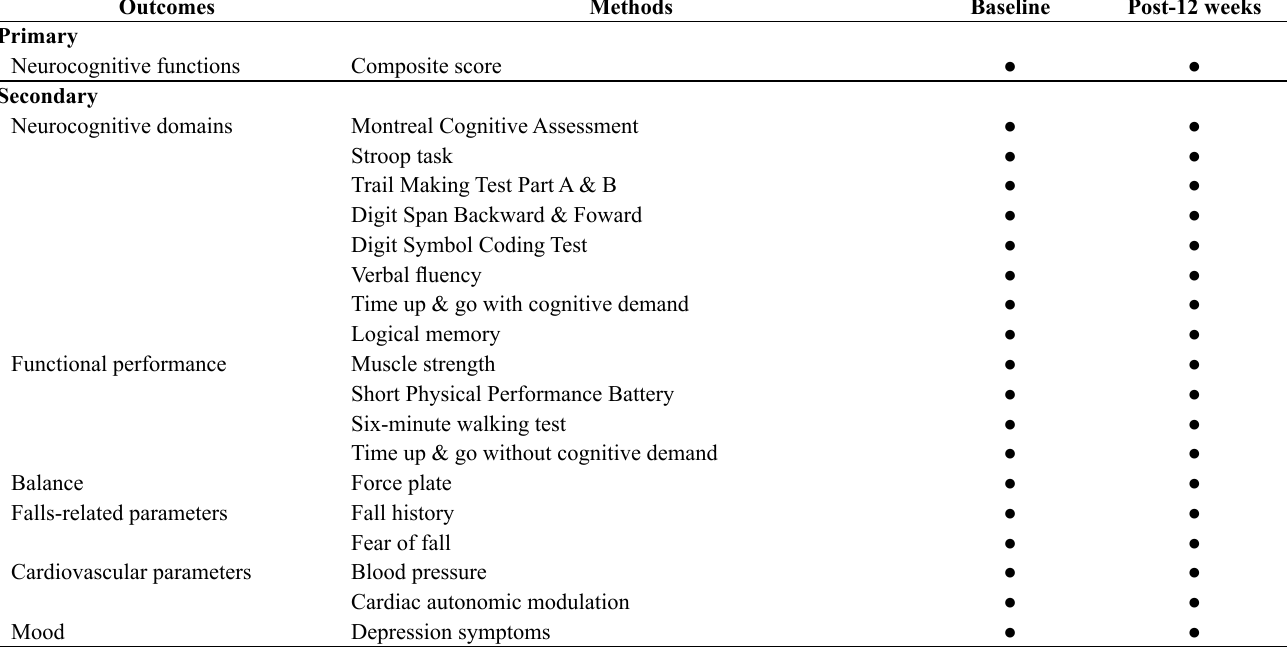
Table 2. REI study outcomes